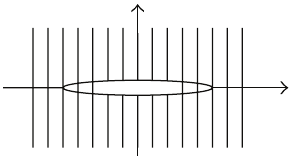
Figure 2: Sketch of crack extension of bridging fibers in fiber reinforced concrete.